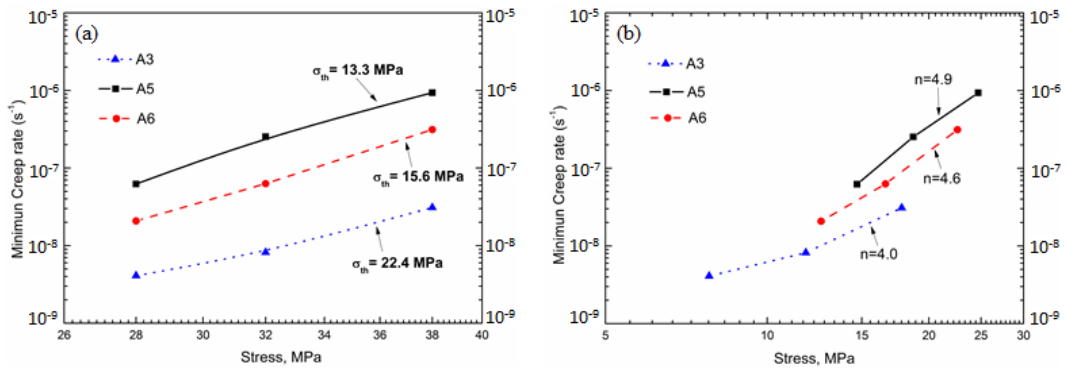
Figure 8. Threshold stress σ th ( a ) and stress exponent n ( b ) in A3, A5 and A6.